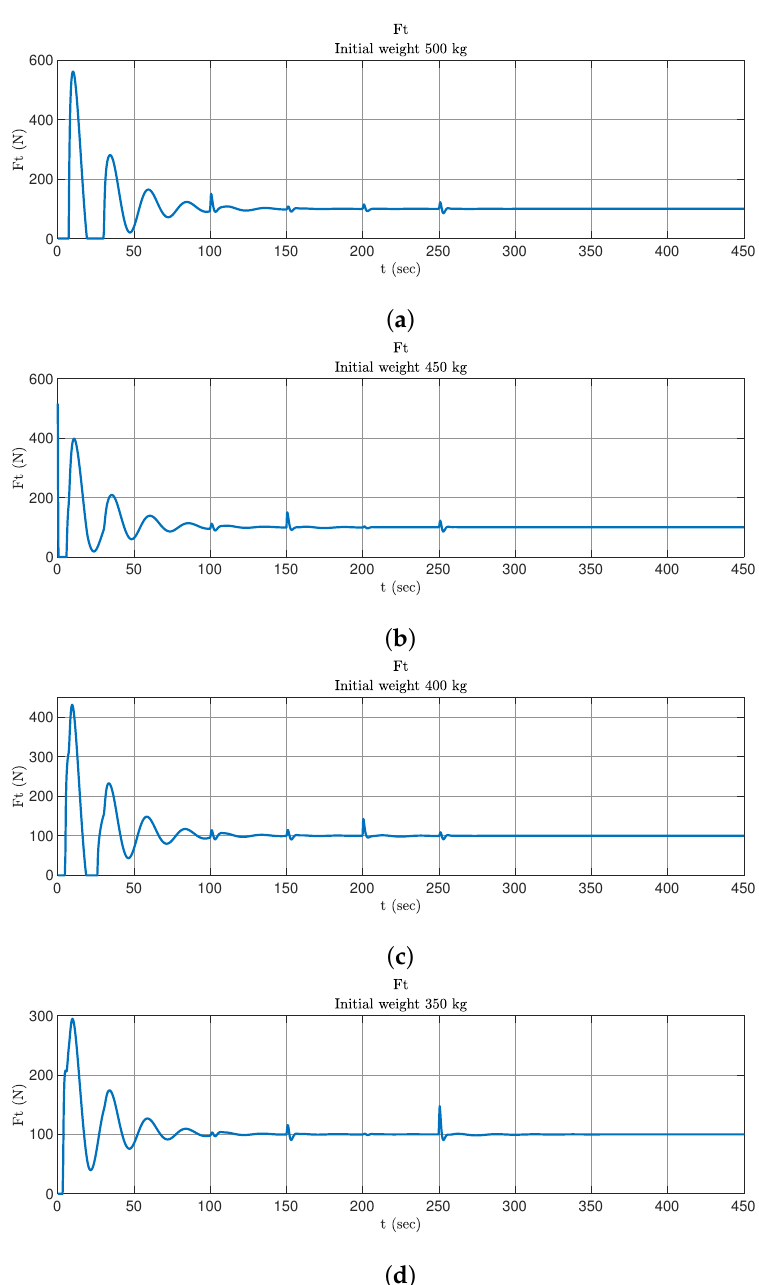
Figure 9. Thrust forces for the case of a group of variable mass UAVs control with initial mass values of 500 kg ( a ), 450 kg ( b ), 400 kg ( c ), and 350 kg ( d